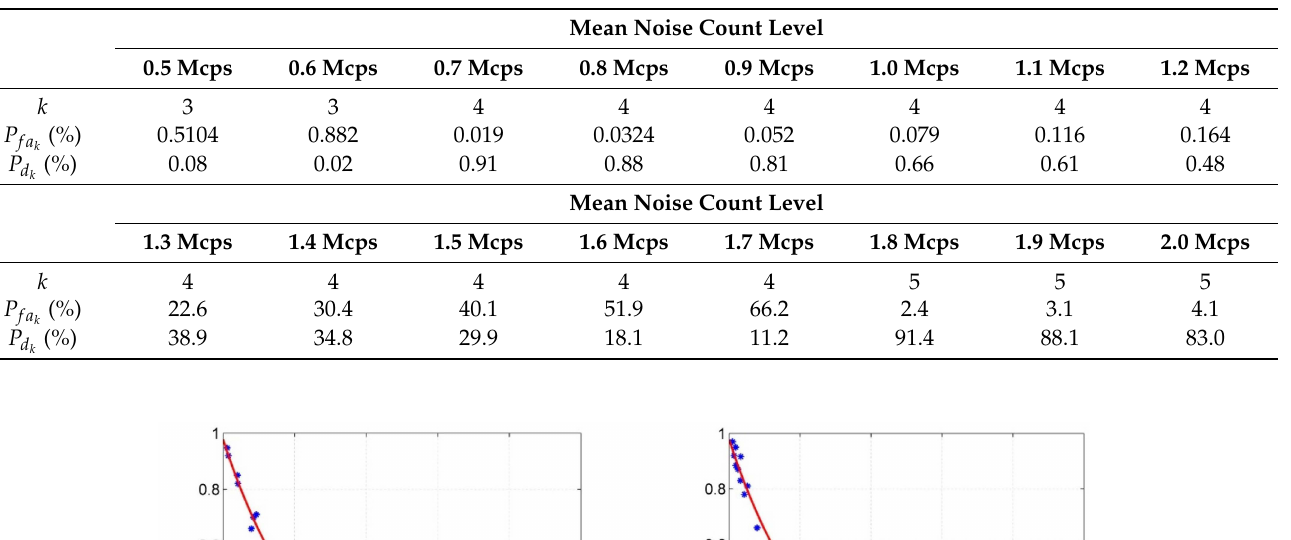
Table 3. Correct ranging probability ( P d ) when the detected signal codes number equals the signal recognition threshold k ( i = k ) and incorrect ranging probability ( P fa ) when the detected noise codes number is equal to or greater than the signal k recognition threshold ( i n ≥ k ) under different mean noise count density.